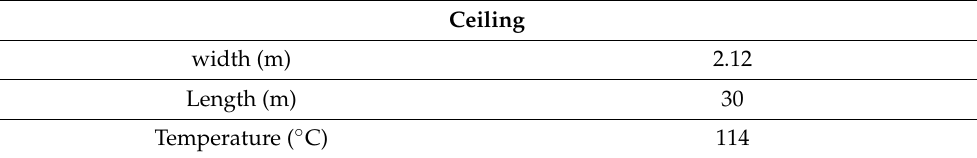
Table 13. Measurements were carried out on the ceiling of the continuous furnace.